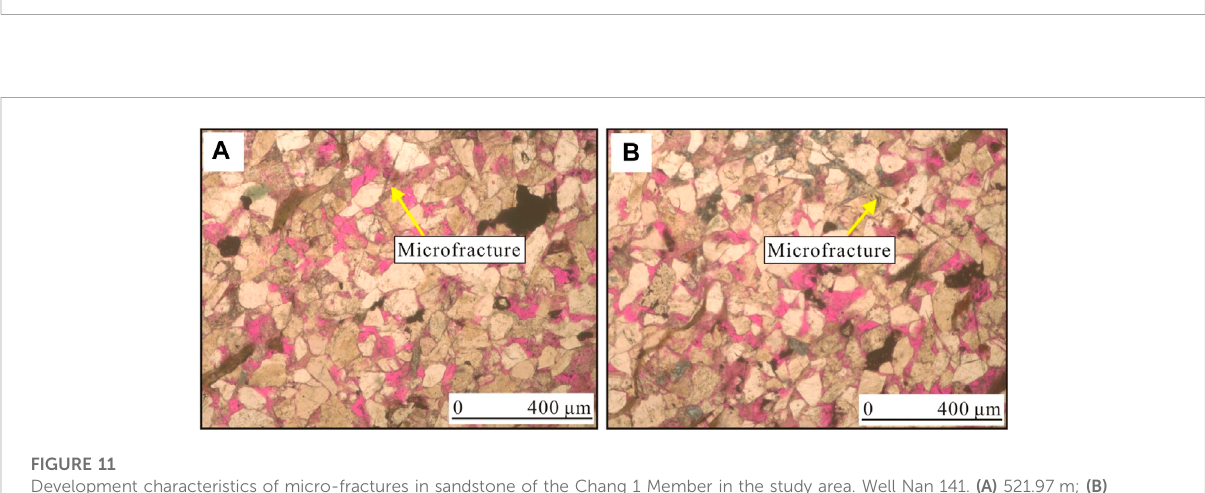
FIGURE 10 Hydrocarbon migration model of the Yanchang Formation in the study area. The superimposed sand bodies and fractures constitute channels for long-term continuous migration of hydrocarbons.